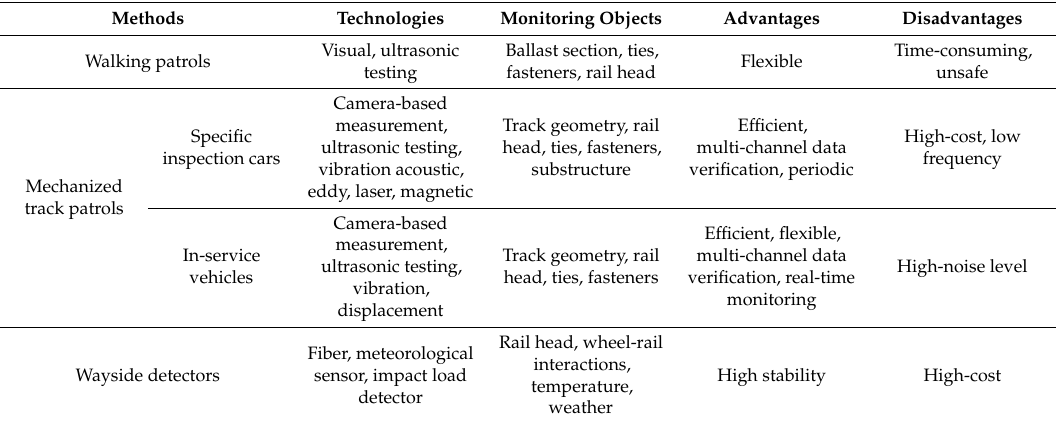
Table 2. Measurement methods in railway track